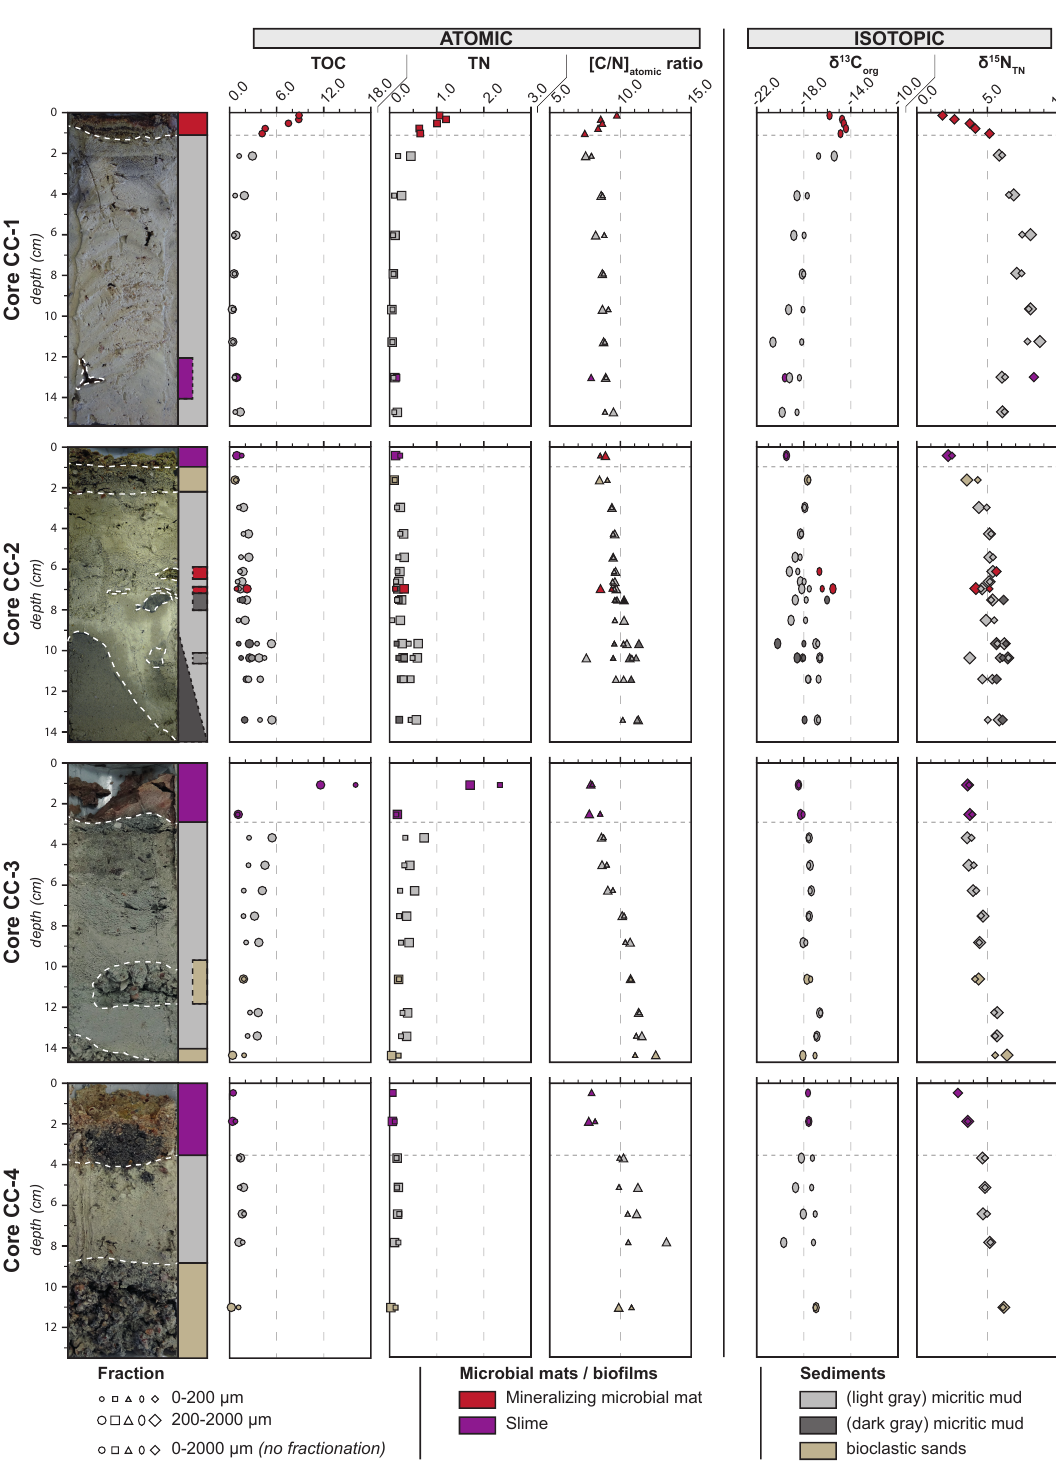
Figure 5. Graphical representation of the elemental (TOC, TN and [C / N] atomic ratio) and isotopic ( δ 13 C org and δ 15 N TN ) analyses made on the four sedimentary cores (please refer to Figure 2 for location and Table 2 for numerical